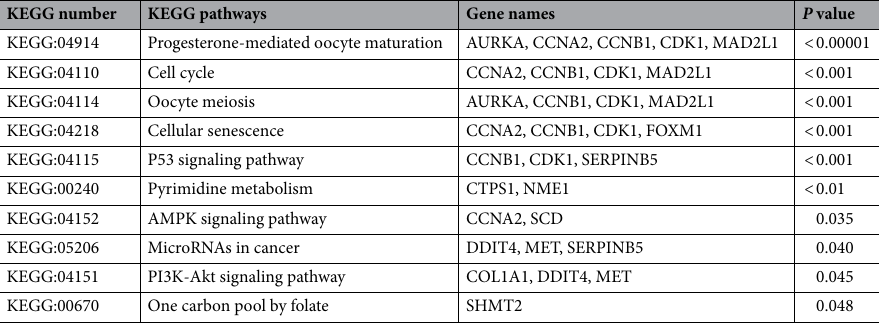
Table 1. Hub genes involved in pathways with P value < 0.05 based on KEGG pathway